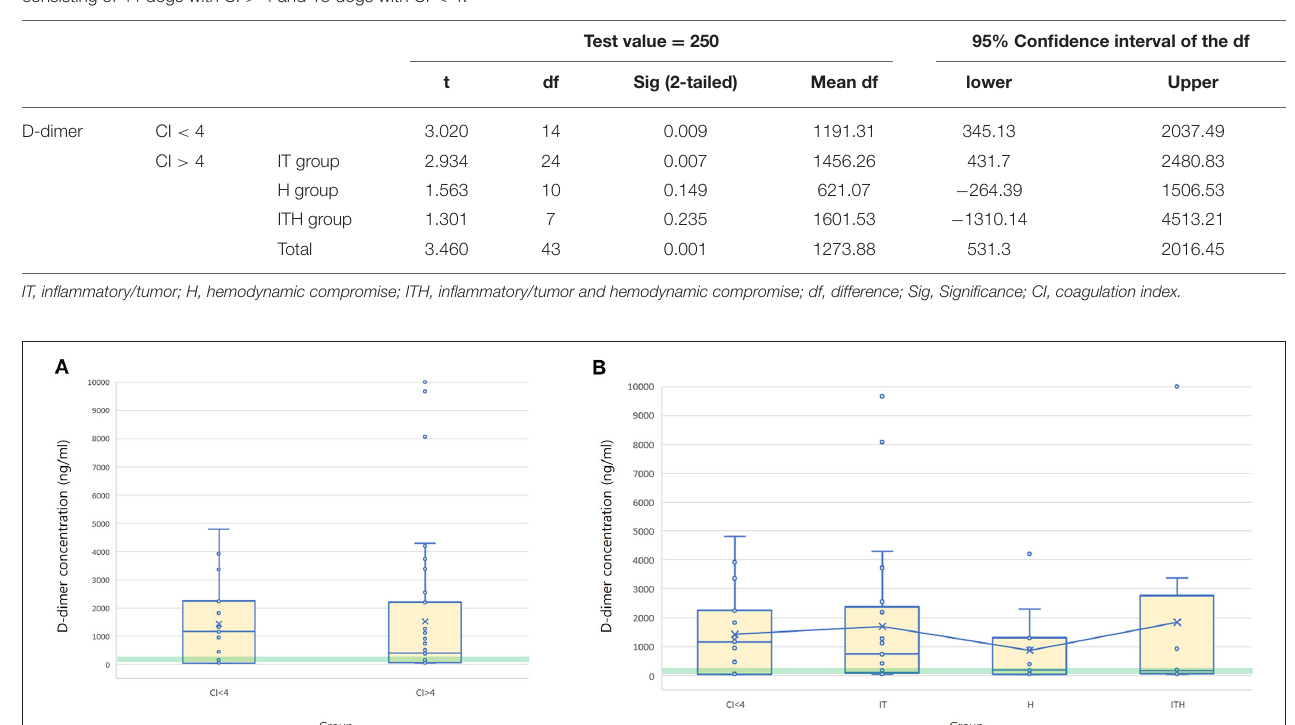
TABLE 2 | One-sample t test for the evaluation of significant difference between the reference and the measured D-dimer concentrations in dogs with critical illness, consisting of 44 dogs with CI > 4 and 15 dogs with CI < 4.